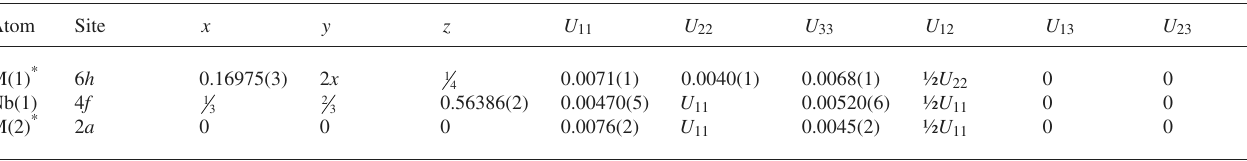
Table 2. Atomic coordinates and displacement parameters (in Å 2 )